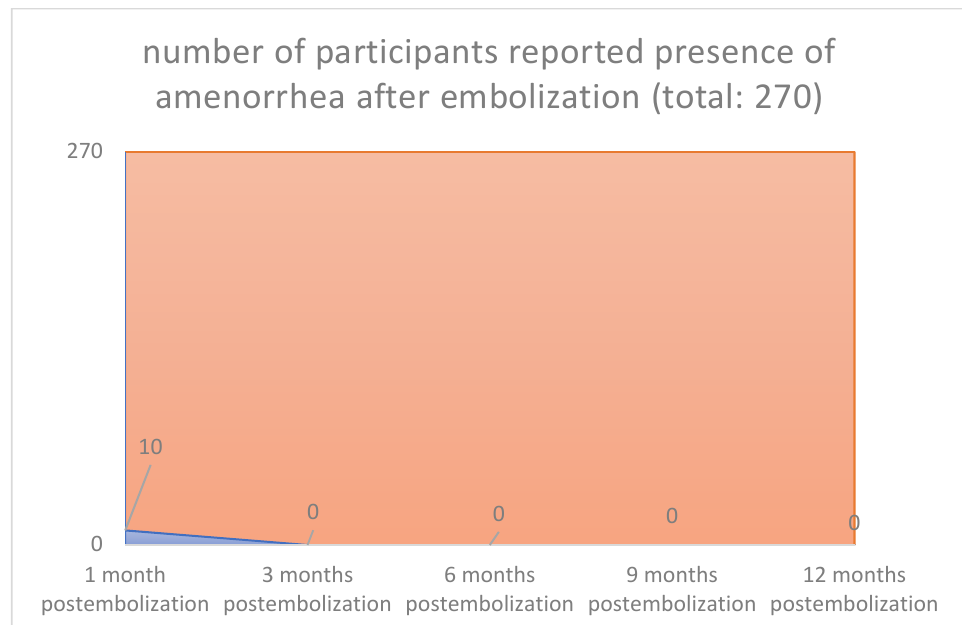
nifi-cantly reduced fluctuation during the menstrual cycle. fluctuation during the menstrual cycle.